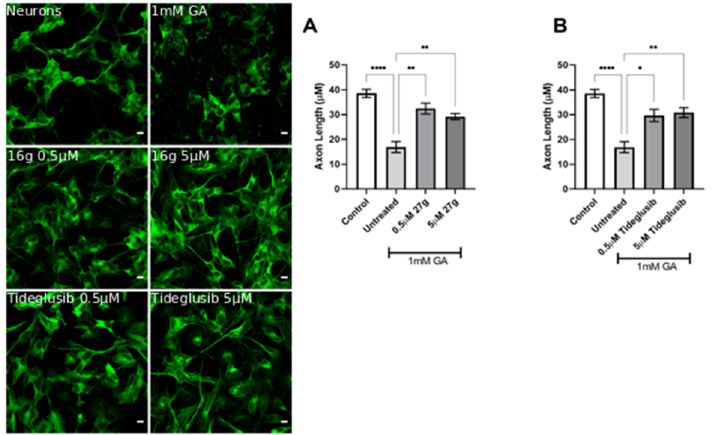
Figure 11. Amelioration of neurite morphology by compound 27g in 1 mM GA-exposed neurons. ( A ) Neurite length quantification of 1 mM GA-treated SH-SY5Y-differentiated neurons after 27g treatment. Scale bar 100 μ M. ( B ) Neurite length quantification of 1 mM GA-treated SH-SY5Y-differentiated neurons after Tideglusib treatment. Ordinary one-way ANOVA followed by Tukey’s post-hoc test was used to compare differences between different groups. Data are presented as mean ± SEM, n = 3 with at least 5 repetitions per experiment,* p < 0.05; ** p < 0.01; **** p < 0.0001.